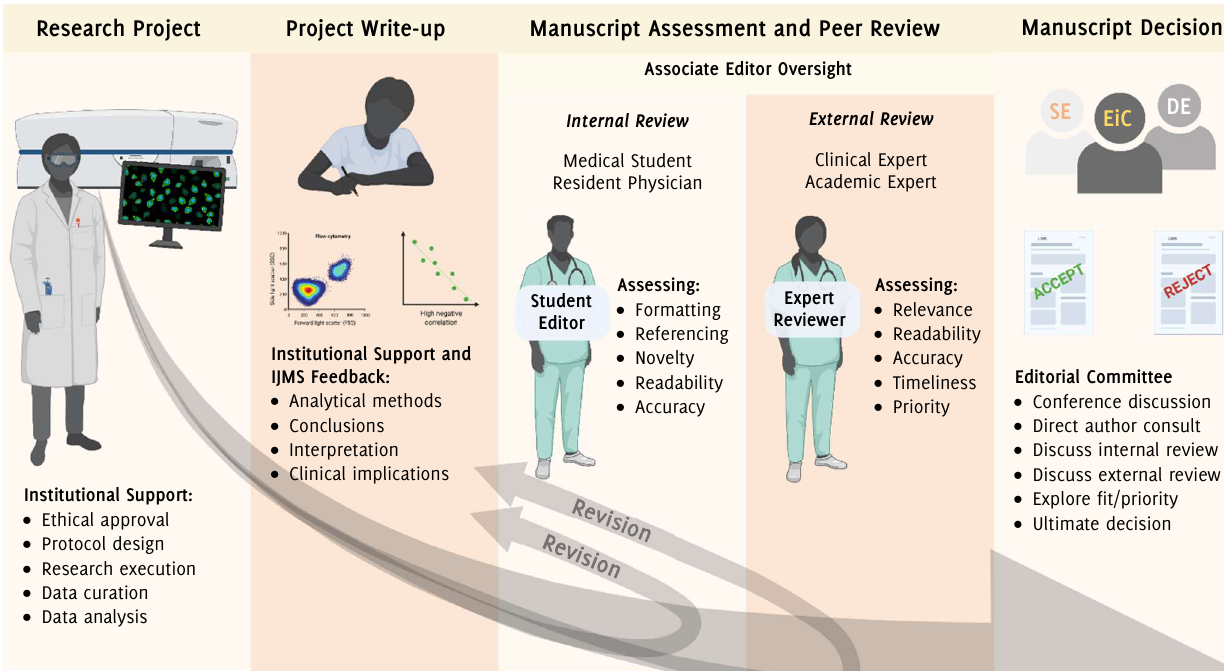
Figure 1 . The Publication Process of the International Journal of Medical Students Aims to Maintain Quality of Submissions and Educate Early Career Authors.